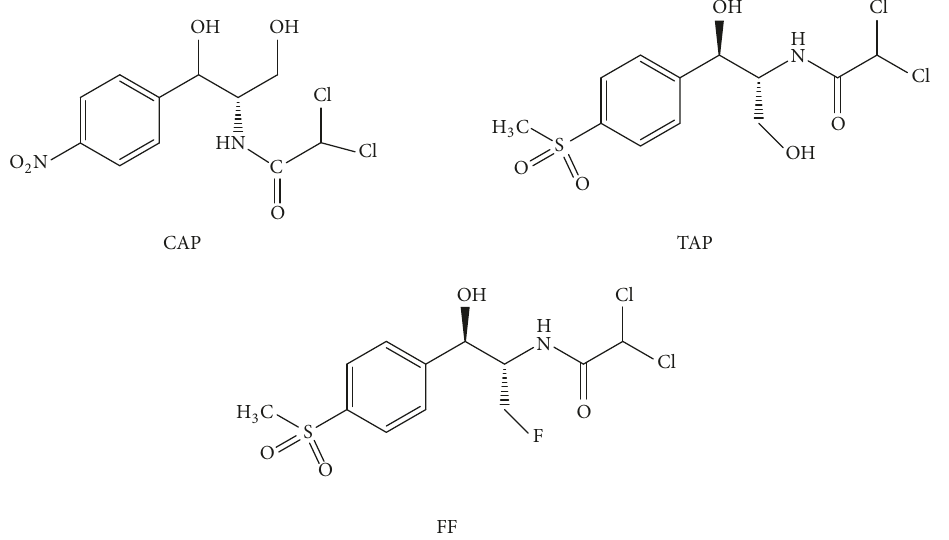
Figure 1: Chemical structures of CAP, TAP, and